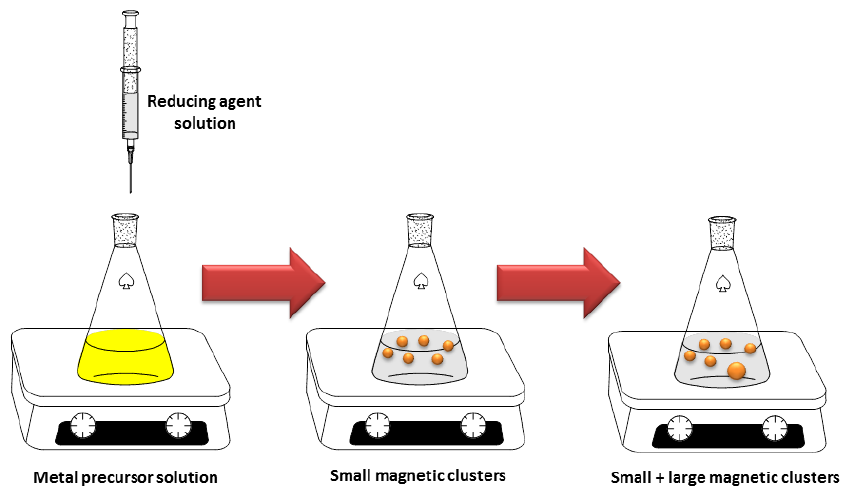
Figure 6. Schematic representation of an alternative and easy method to produce OM / noble metal NPs.